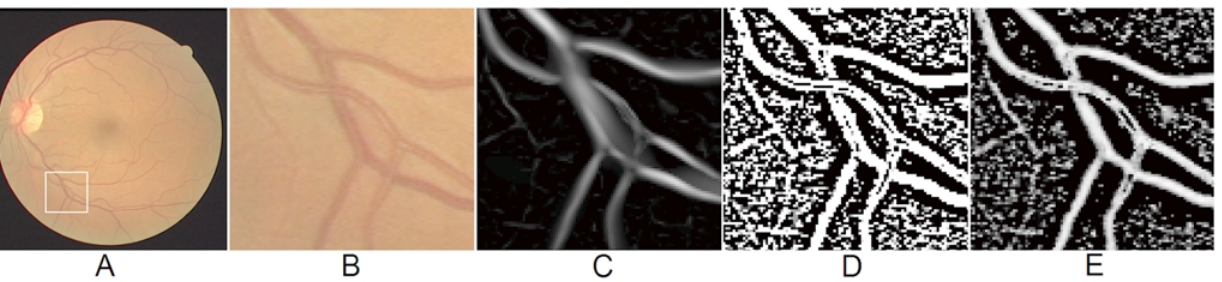
Fig 4. Enhancement results on selected region with vascular bifurcation and crossover produced by an eigenvalue-based method [28], a wavelet- based method [17] and the local phase method, respectively. (A) A randomly chosen image from the DRIVE dataset. (B) Selected region with vascular bifurcation and crossover. (C) Eigenvalue-based enhancement results. (D) Wavelet-based enhancement results. (E) Local phase based enhancement